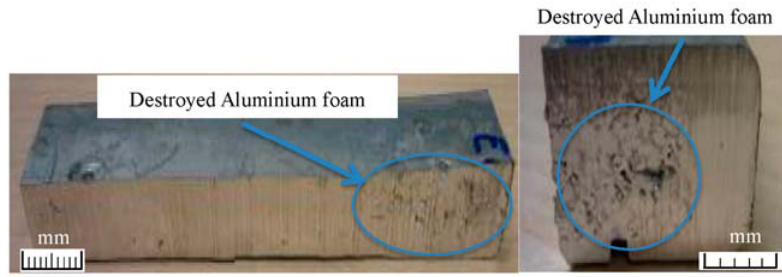
Figure 12. HPDC part with totally destroyed aluminium foam.